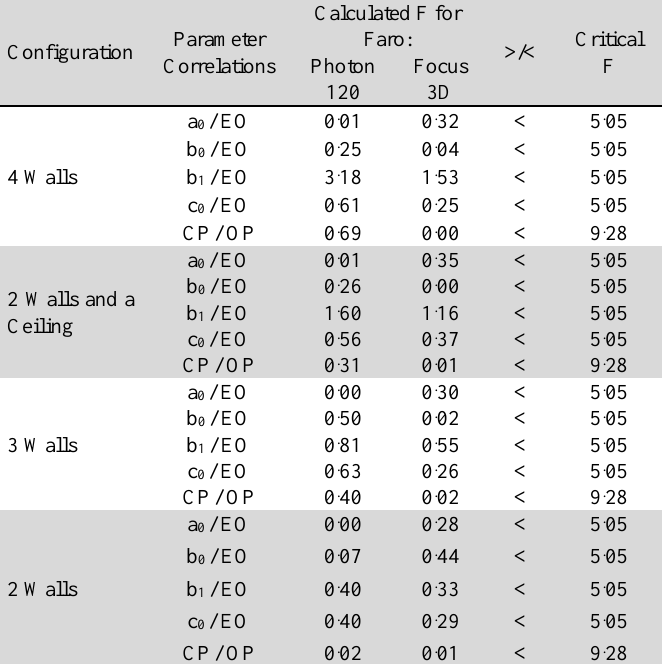
Table 3. F-variance ratio test for different surfaces